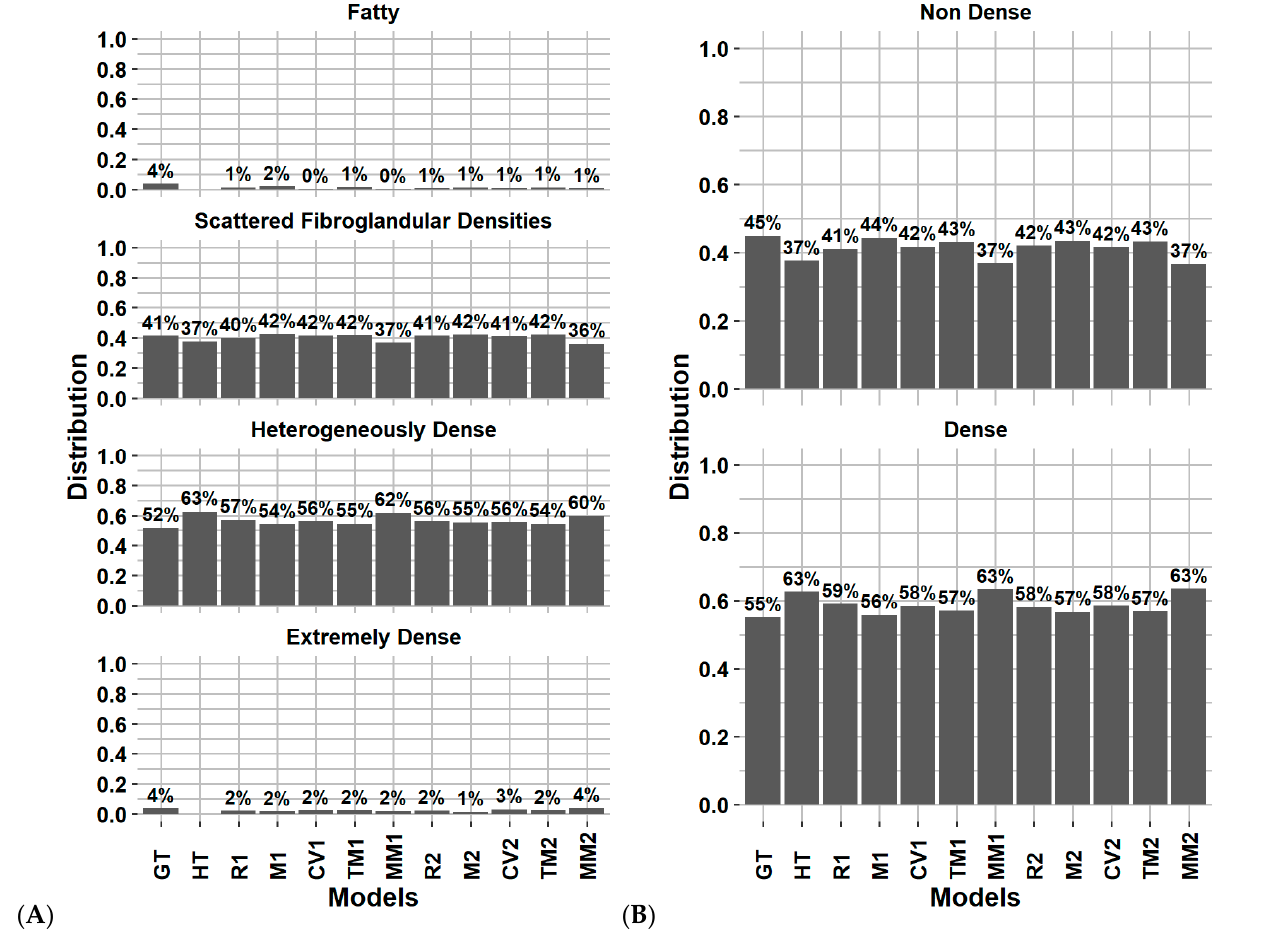
Figure 5. Distribution of breast density category assignment for the ground truth and DL models on for ( A ) 4 categories and ( B ) 2 categories, on the test dataset considering every screening (except H). Abbreviations: GT: ground truth (clinical reader), HT: history model, R1: for processing, M1: for presentation, CV1: synthesized 2D, TM1: digital breast tomosynthesis, MM1: Multi model, 2: in ‐